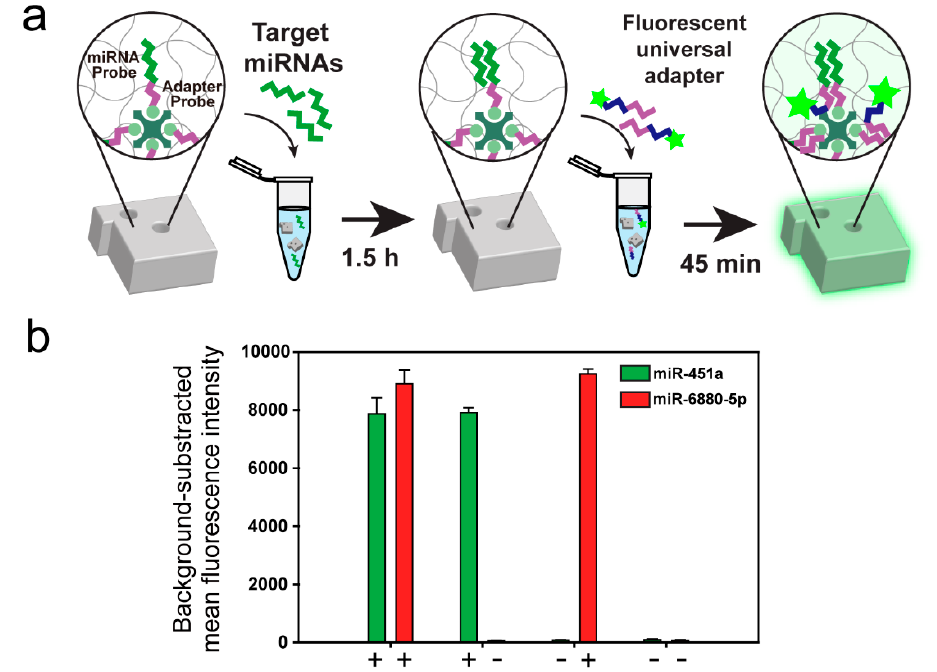
Figure 4. Multiplex detection of cancer-related miRNAs using streptavidin-conjugated encoded hydrogel microparticles. ( a ) Schematic illustration of the miRNA assay protocol. ( b ) Specificity test using two cancer-related miRNAs. The plus and minus signs represent the presence ( + ) or absence ( − ) of the target.